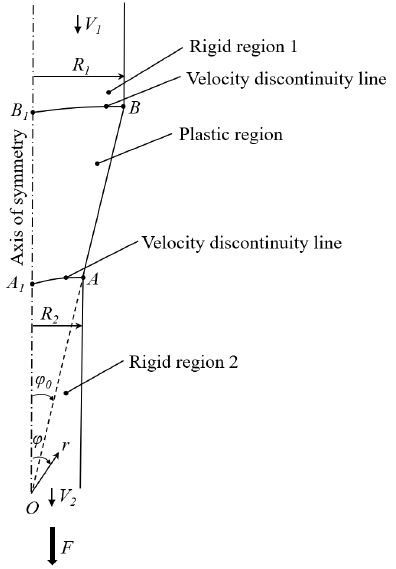
Figure 2. General structure of the kinematically admissible velocity field.